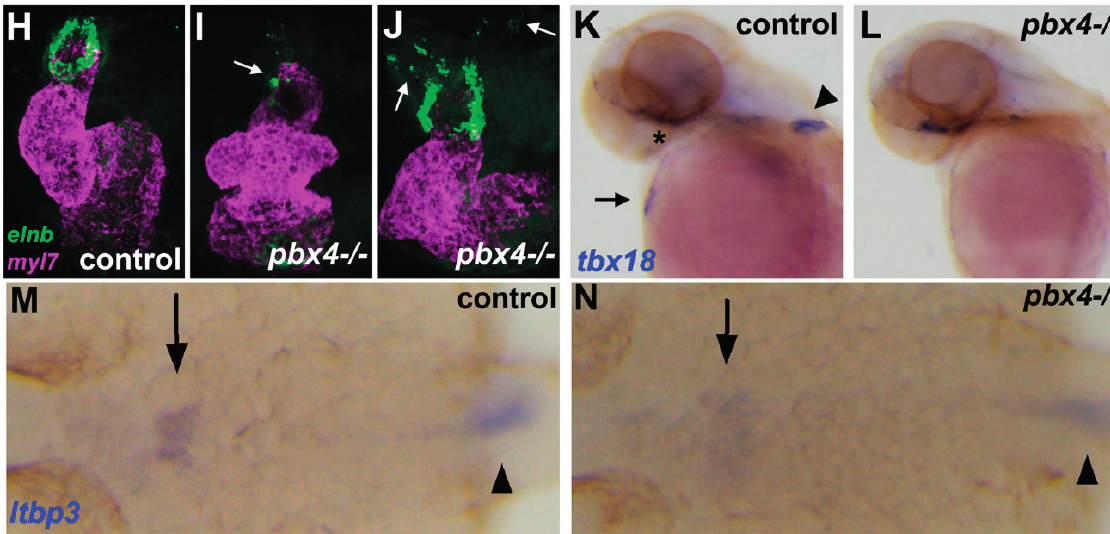
Figure 4. Cardiac chamber, outflow tract, and proepicardial development defects in pbx4 mutant embryos. ( A , B ) RNA in situ expression of cardiomyocyte differentiation gene myl7 (red) at 48 hpf in ( A ) control ( n = 16) and ( B ) pbx4 b557 -/- ( n = 4) embryos. V, ventricle. A, atrium. Arrow in ( B ) points to abnormal bulge in pbx4 b557 -/- ventricle. ( C , D ) Cardiomyocyte nuclei (magenta) in 26 hpf Tg(myl7:h2afva-mCherry) sd12 ( C ) control ( n = 13) and ( D ) pbx4 b557 -/- ( n = 9) embryos. ( E , F ) Cardiomyocyte nuclei (magenta) in 48 hpf Tg(myl7:h2afva-mCherry) sd12 ( E ) control ( n = 9) and ( F ) pbx4 b557 -/- ( n = 7) embryos. Tg(myh6:EGFP) s958 (green) is used to identify atrial cells. ( G ) Graph displaying cardiomyocyte nuclei count data at 26 hpf and 48 hpf. Error bars represent standard deviation. * P < 0.00003. ( H , J ) RNA in situ expression of outflow tract smooth muscle marker elnb (green) and myl7 (magenta) at 72 hpf in ( H ) control and ( I , J ) pbx4 b557 -/- embryos. In control embryos ( n = 15), elnb expression appears as a ring ( H ). In pbx4 b557 -/- embryos, elnb expression can appear reduced (arrow in I ; 5/9 embryos) or expanded and bifurcated (arrows in J ; 4/9 embryos). ( K , L ) RNA in situ expression of tbx18 at 48 hpf in ( K ) control and ( L ) pbx4 b557 -/- embryos. tbx18 expression in pectoral fin (arrowhead) and proepicardial cells (arrow) is lost in pbx4 b557 -/- embryos ( n = 9) compared to controls ( n = 11), while facial expression (asterisk) is maintained. Hearts and embryos are shown in ventral view, anterior toward the top. ( M , N ) RNA in situ expression of ltbp3 at 24 hpf in ( M ) control and ( N ) pbx4 b557 -/- embryos. ltbp3 expression in second heart field domain (arrows) appears broader yet weaker in pbx4 b557 -/- embryos ( n = 10, all weaker